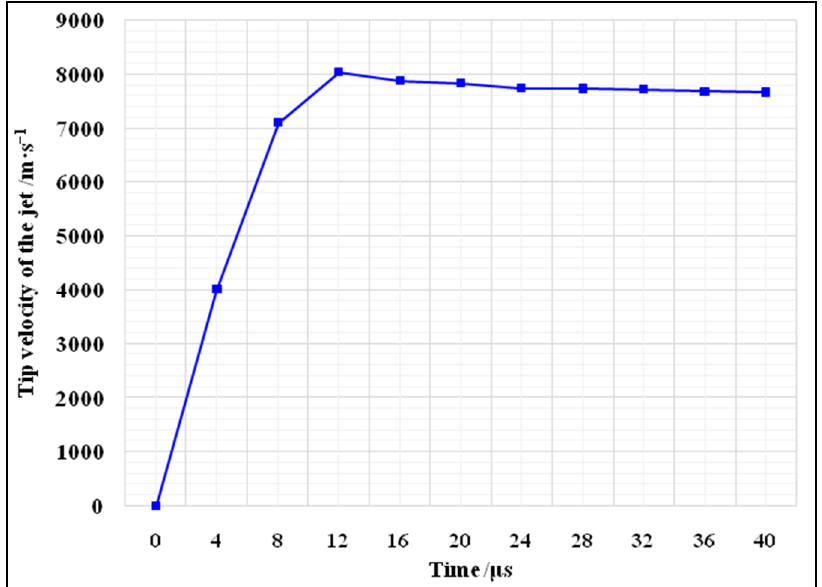
Figure 3. The head-velocity variations of the jet with time during the period of 0–40 μs.